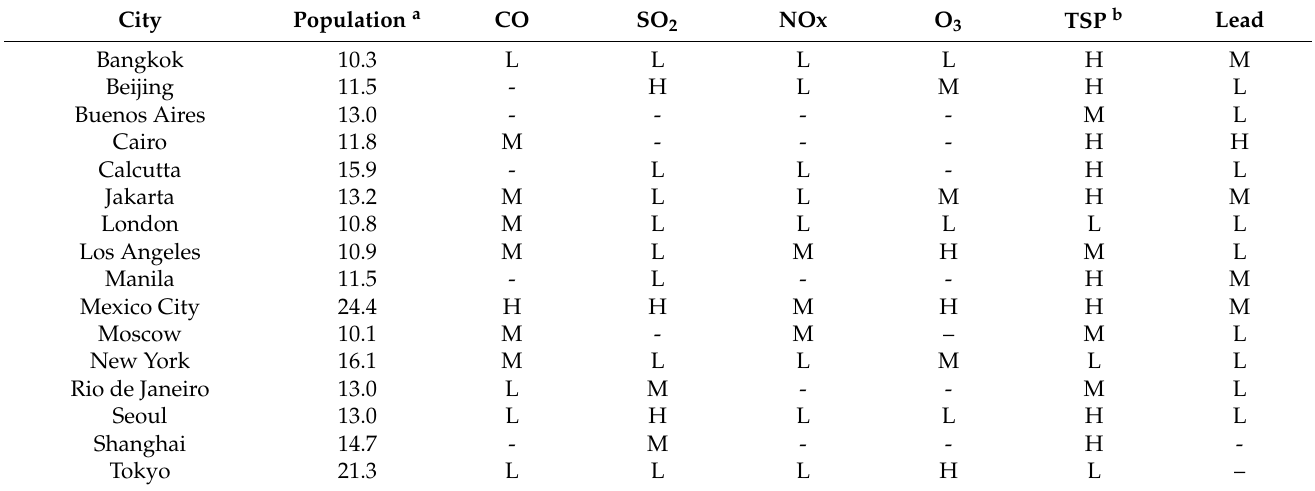
Figure A1. Change in the global mean temperature (1880–2020). Note that the graph emphasizes the rapid warming at the surface relative to the 1970s, suggesting a continued sharp increase in the near future. (Graph courtesy of NASA). Table A1. Reactant or product indicators for urban chemistry for major cities. H = High concentrations exceeding WHO regulatory air pollution guidelines by more than 2 × ; M = Moderate concentrations exceeding WHO guidelines by less than 2 × ; L = low WHO guidelines generally met; and – Inadequate data. (Based on tabulations from Harrington and McConnell